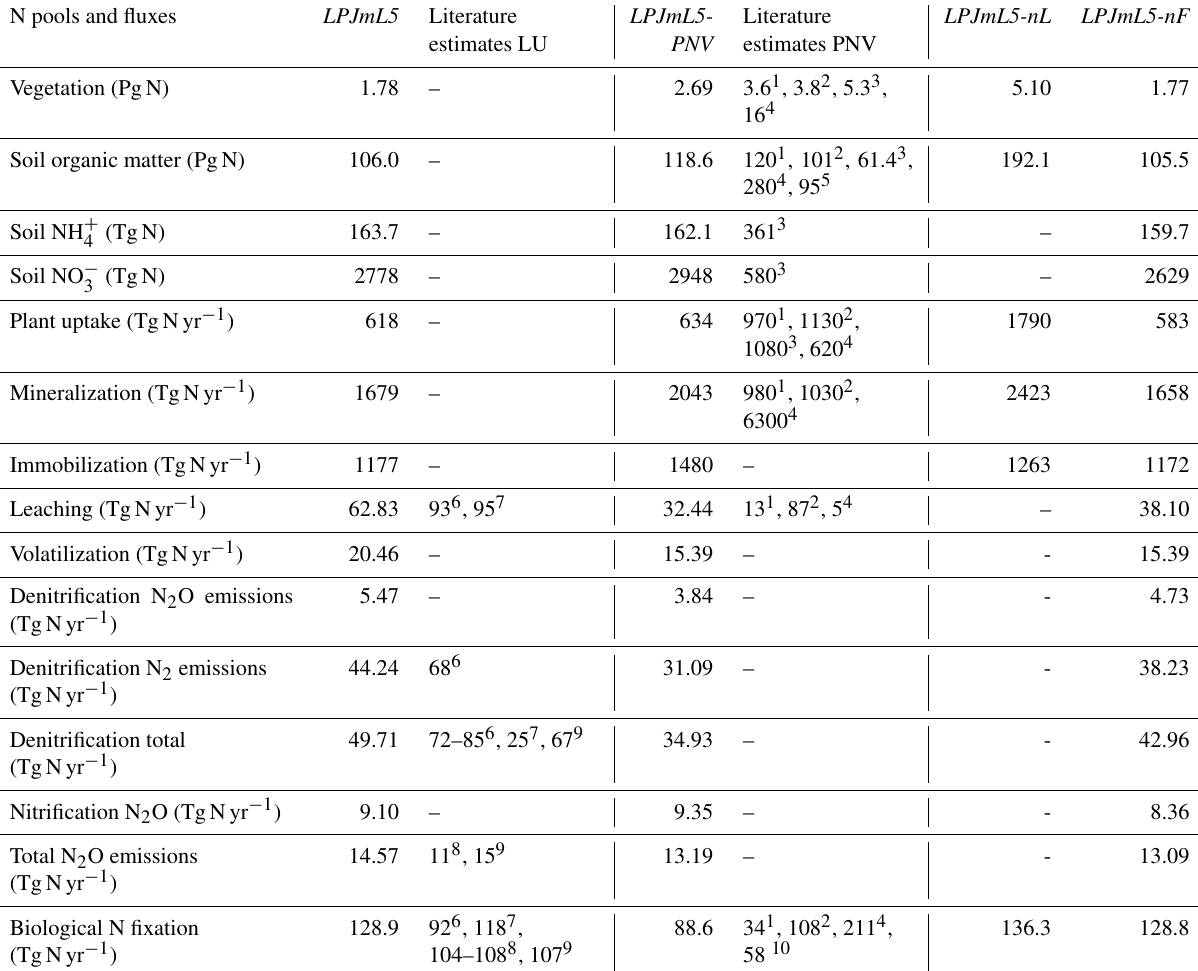
Table 4. Global nitrogen pools and fluxes for the four different experiments with LPJmL5 and literature estimates (averages over the period 2000 to 2009). The suffix -PNV denotes experiments with potential natural vegetation, -nL with unlimited N supply, and -nF without fertilizer